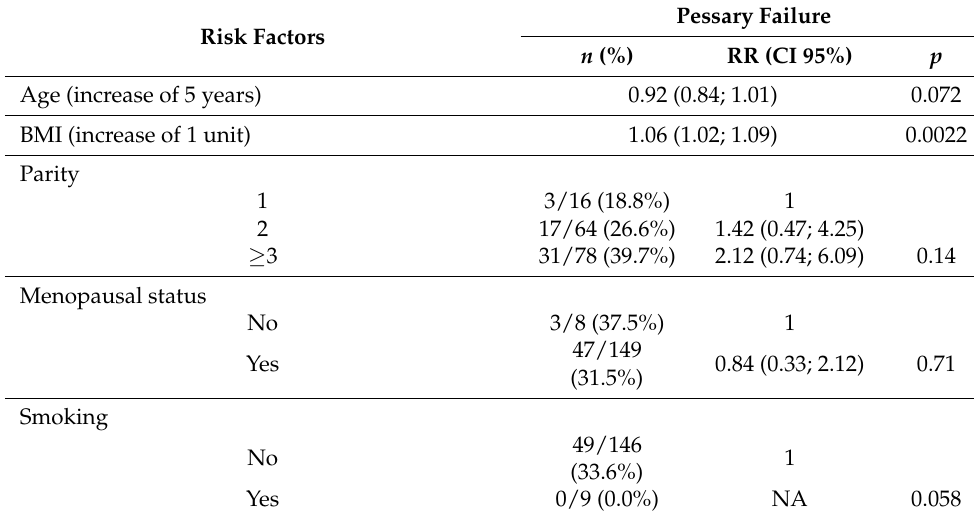
Table 5. Factors associated with pessary failure at six months (using log-binomial